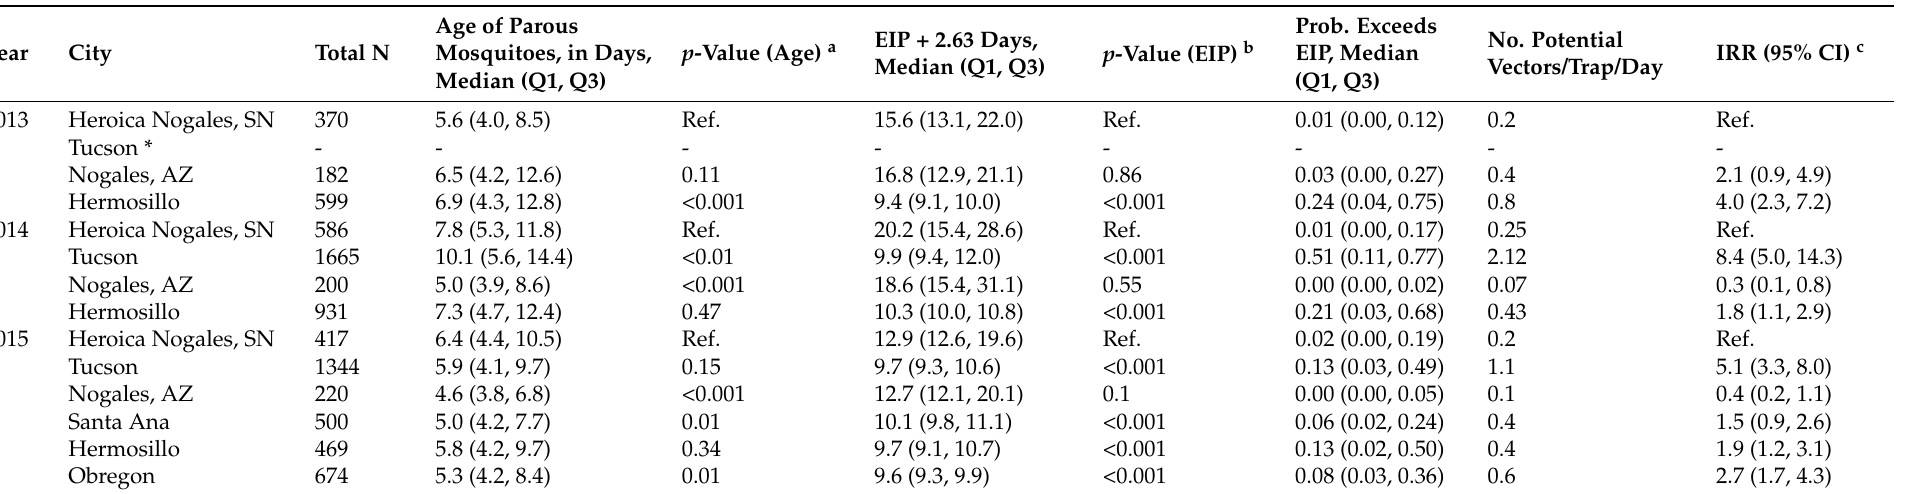
a Logistic regression for binomial proportions b Wilcoxon rank sum test with continuity correction c Negative binomial regression model stratified by collection cycle and year, relating count of potential vectors per household collection site with log (trap days) as offset and with city as a predictor. * Ref. indicates the city used for comparisons. July Tucson 2013 missing due to differing RNA extraction methods used for mosquito samples during that collection